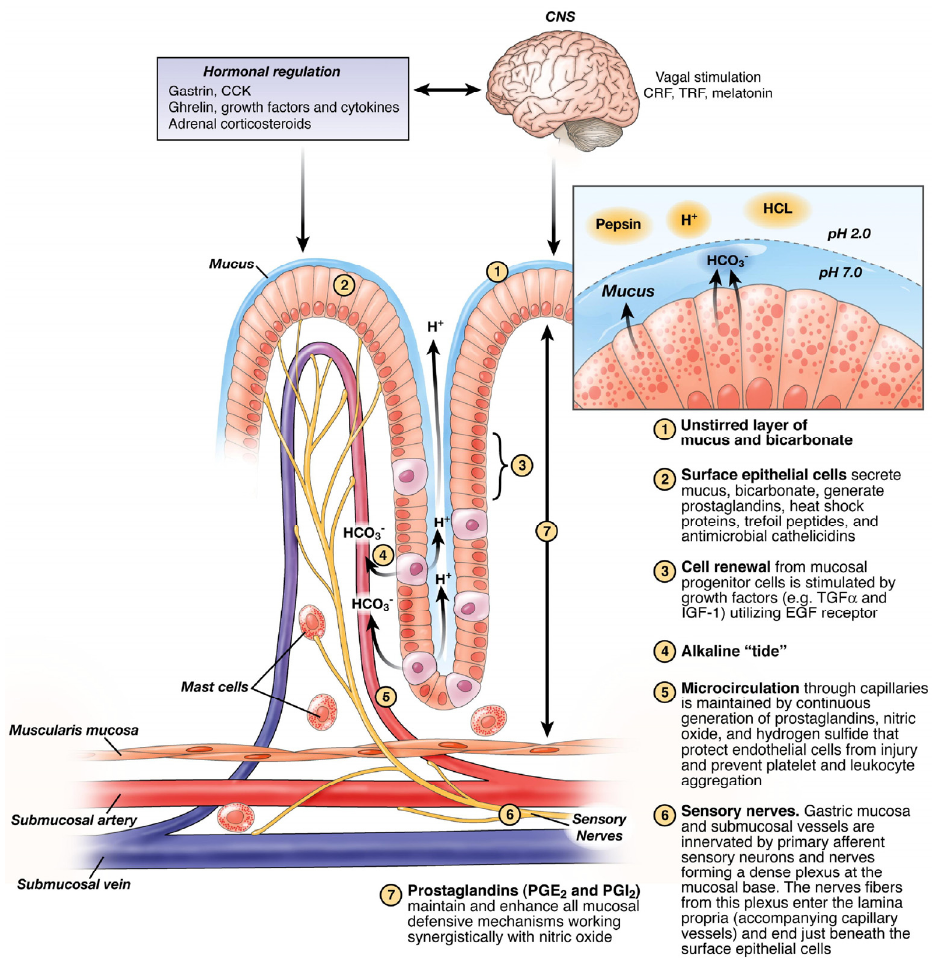
Figure 2. Mucosal defense. A diagrammatic representation of gastric mucosal defense (designed by A. Tarnawski; reprinted with permission from [4]). A. Tarnawski; reprinted with permission from